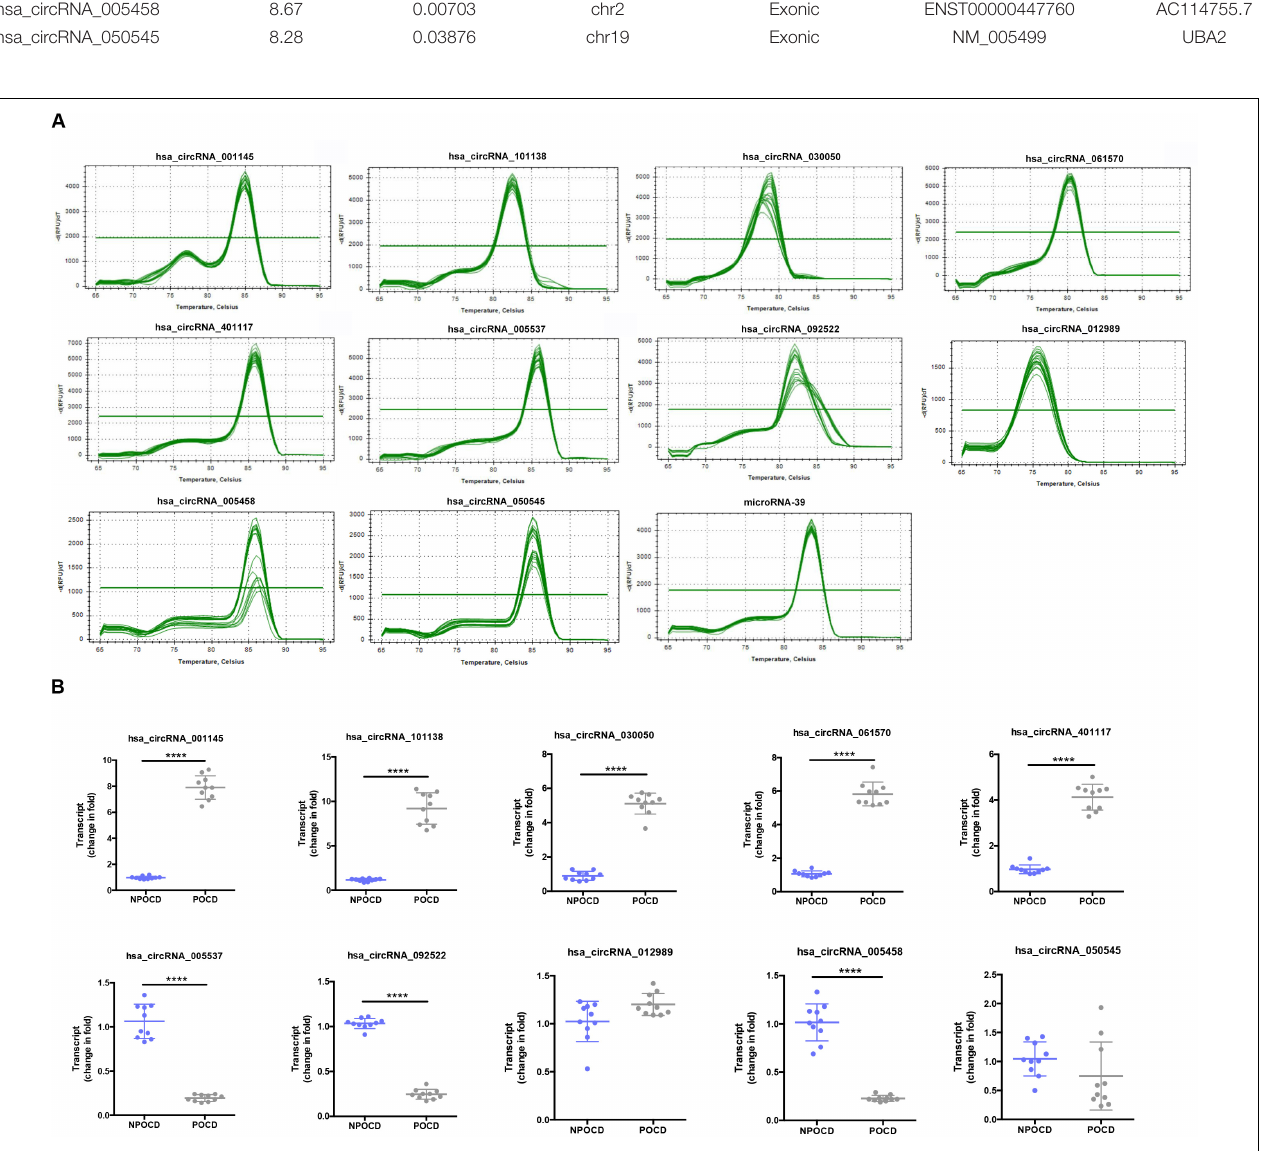
FIGURE 3 | Amplification and identification of differentially expressed circRNAs. (A) The melt curves of the identified distinguishable expressed circRNAs. (B) qRT-PCR showing the expression levels of circRNAs between the two groups. Data are presented as means ± SD. ****P < 0.0001, N = 10.